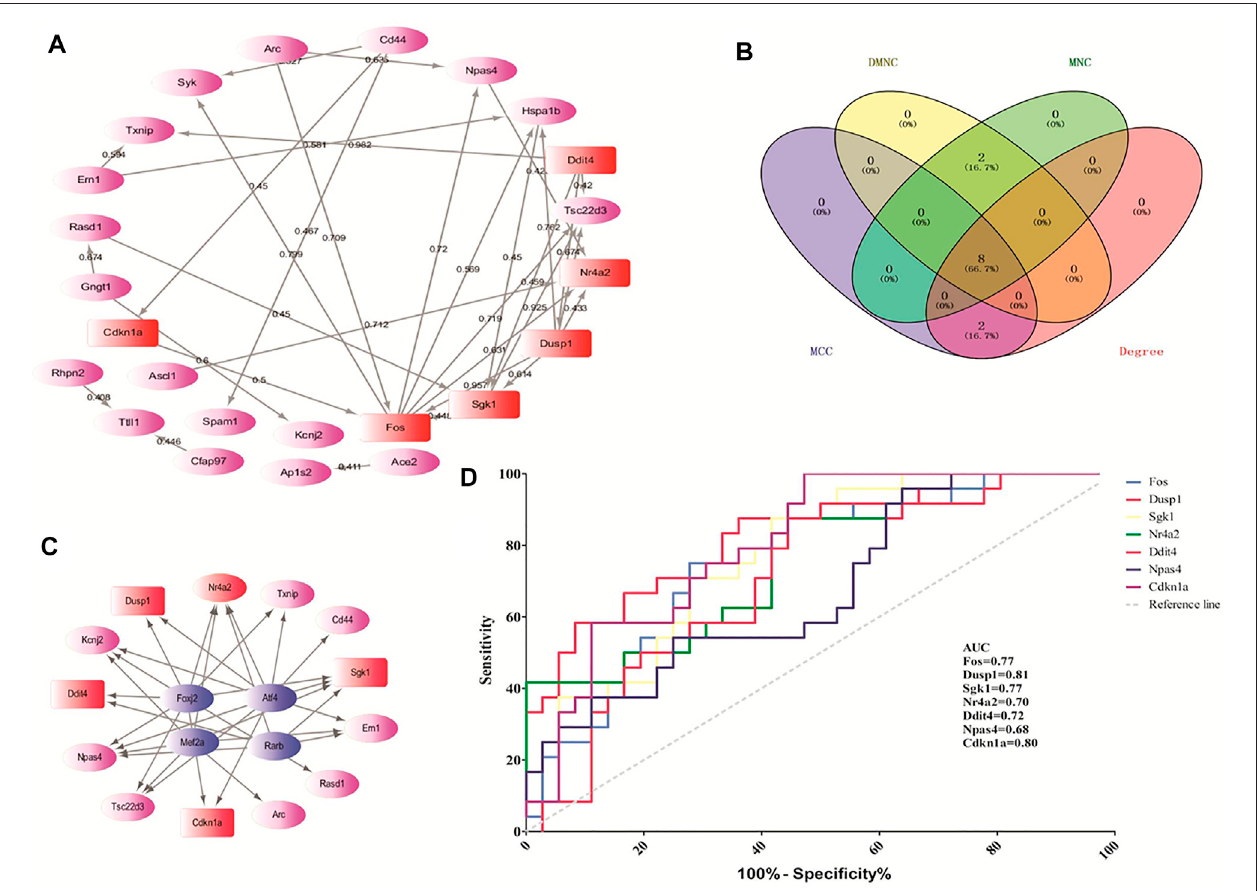
FIGURE5| ThehubgenesscreenedbytheCytoHubbapluginandpredictedbyreceiveroperatingcharacteristic(ROC)curve.Theprotein – proteininteraction(PPI) network of CDEGs (A) . Venn diagram of the top 10 hub genes by MCC, DMNC, MNC, and degree algorithms (B) . The PPI network of TF-target genes by the iRegulon plugin (C) . The ROC curve-predicted hub genes in GSE15774 (D) . Red indicates the hub genes. Pink indicates the other DEGs. Blue indicates TF-target genes.